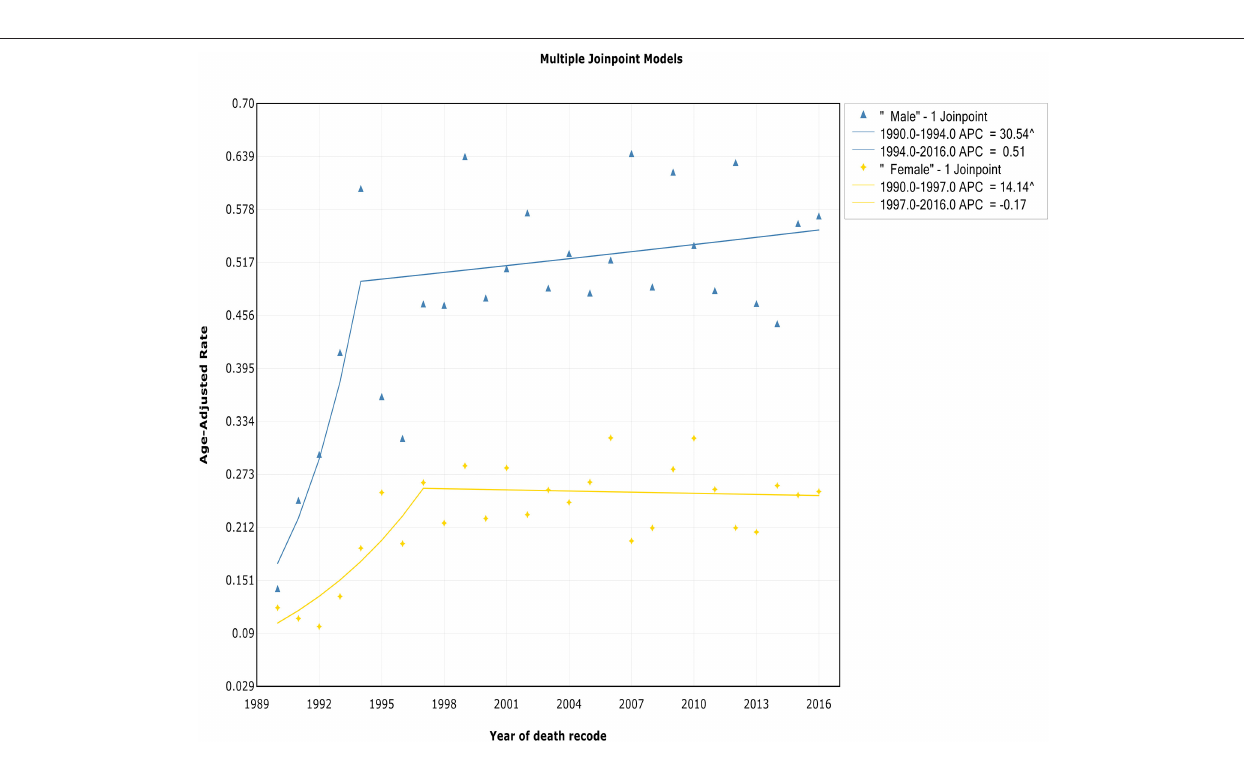
Frontiers in Oncology |